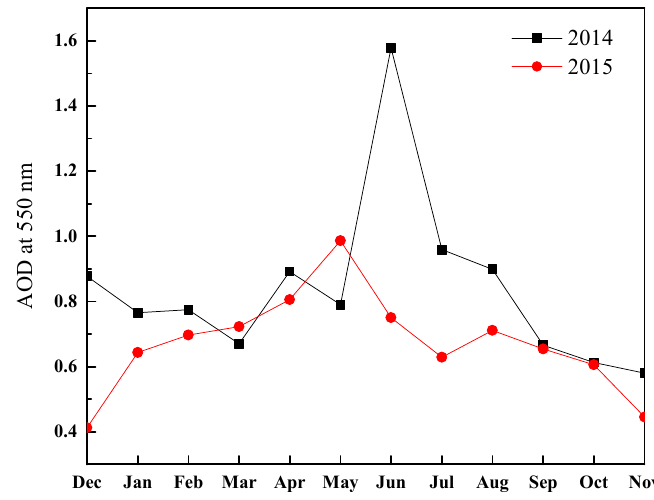
Figure 4. Monthly mean aerosol optical depth (AOD) map of area-averaged time series over urban Hefei (region: 116.5–117.5 ° E, 31–32 ° N) derived from MODIS-Terra data in 2014 and 2015.